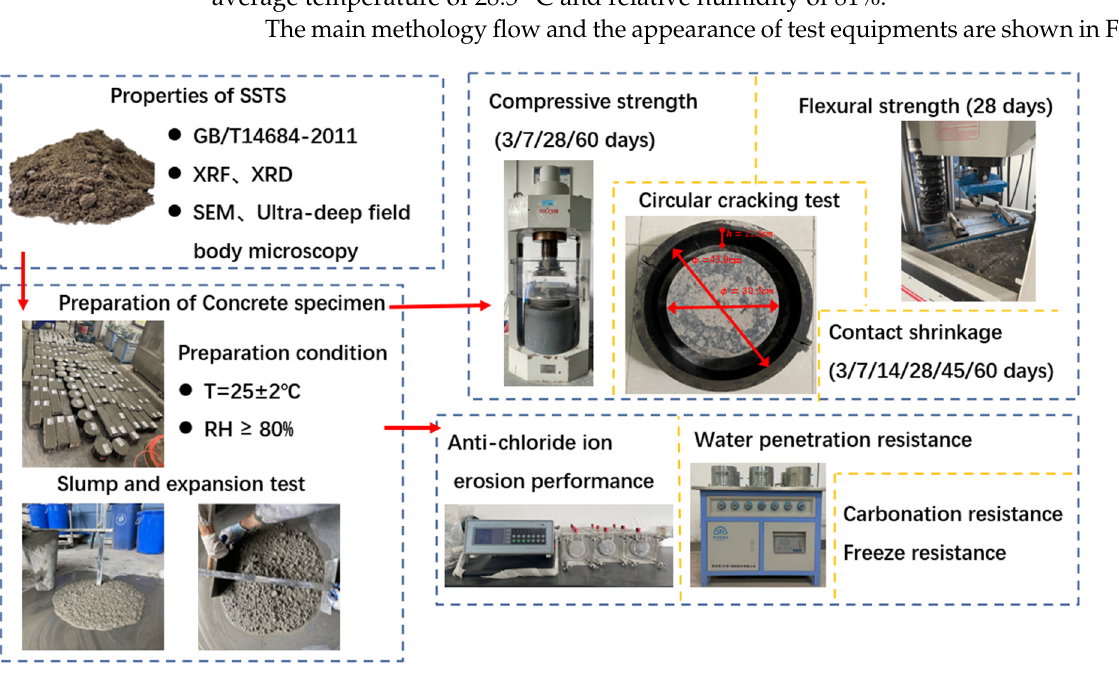
Figure 7. Main methodology flow